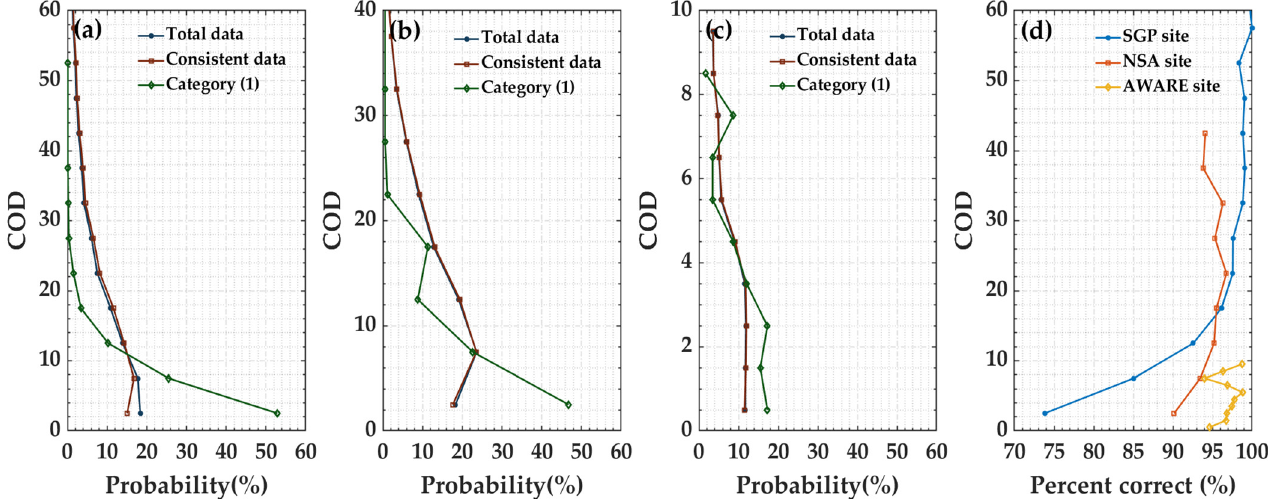
Figure 7. The proportion of total data, consistent data, and category (1) under different CODs of total testing set at ( a ) SGP site, ( b ) NSA site, and ( c ) AWARE site. ( d ) The PC of SGP site, NSA site, and AWARE site under different CODs.